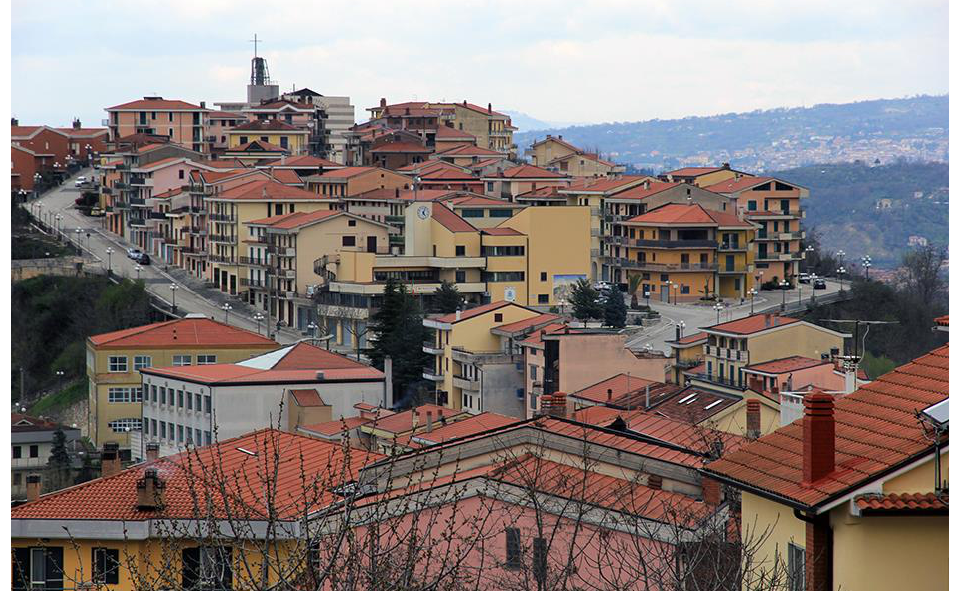
Figure 55. San Mango sul Calore: Panoramic view of the village completely rebuilt after the 1980 earthquake (photos by